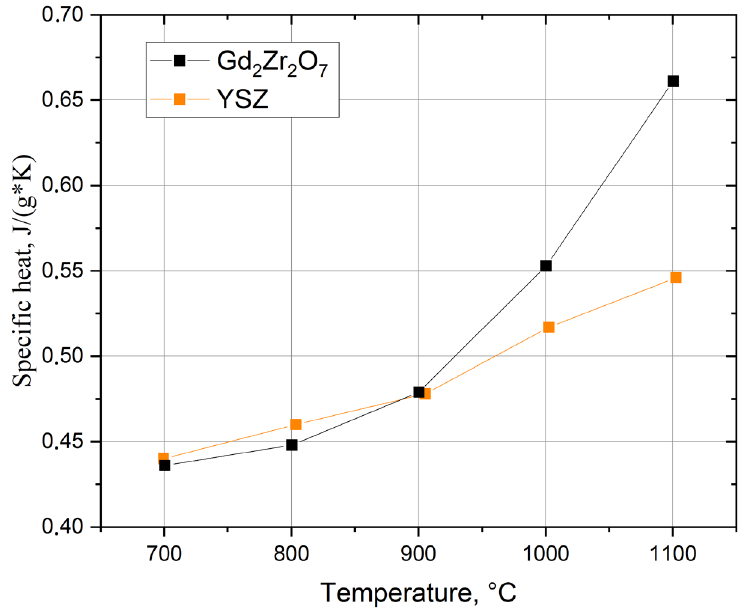
Figure 4. Specific heat of Gd 2 Zr 2 O 7 (GZO-2200A) and YSZ (YSZ-2200A) in the temperature range 700–1100 °C.